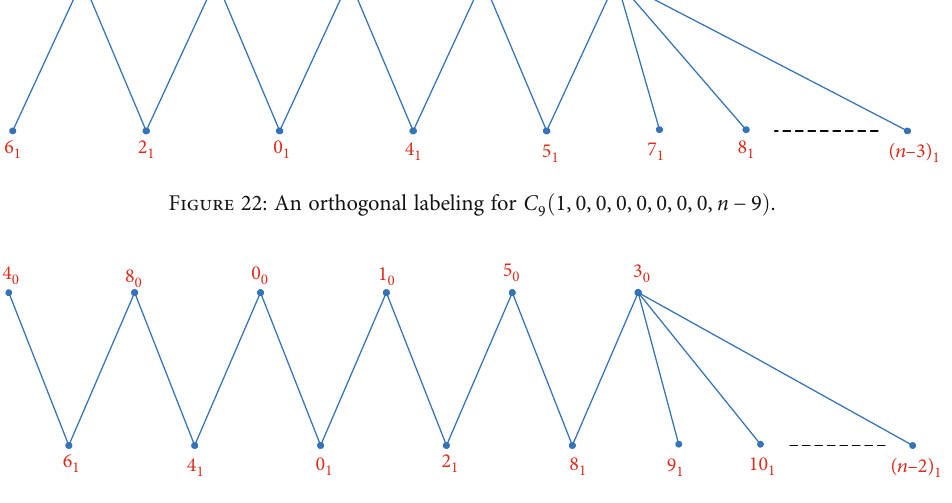
Figure 23: An orthogonal labeling for C